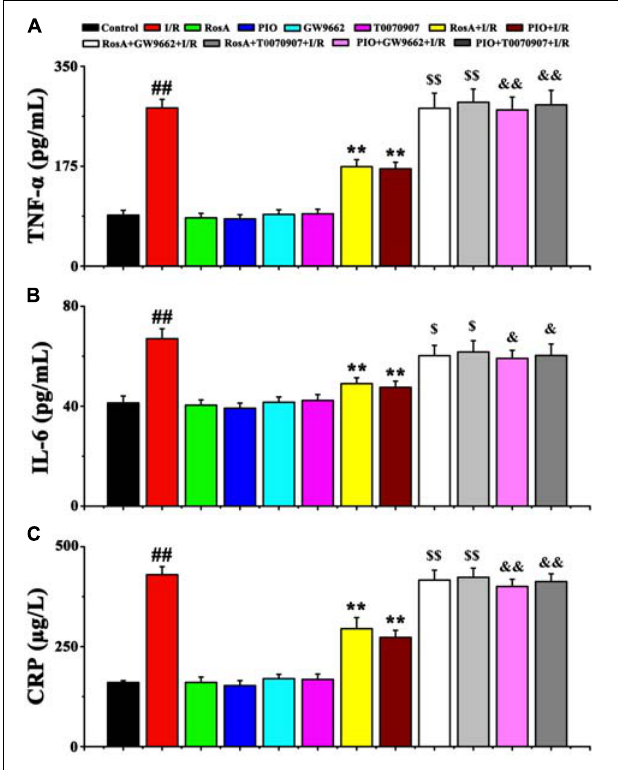
FIGURE 3 | The effect of RosA on inflammatory cytokine production in rat model of cardiac I/R. Values are presented as means with their standard deviation, n = 6. The effect of RosA on TNF- α (A) , IL-6 (B) , and CRP (C) levels in I/R rat model. ## P < 0.01 compared with control group; ∗∗ P < 0.01 compared with I/R group. Compared with the I/R+RosA group, $ P < 0.05, $$ P < 0.01. Compared with the I/R+PIO group, & P < 0.05, && P <